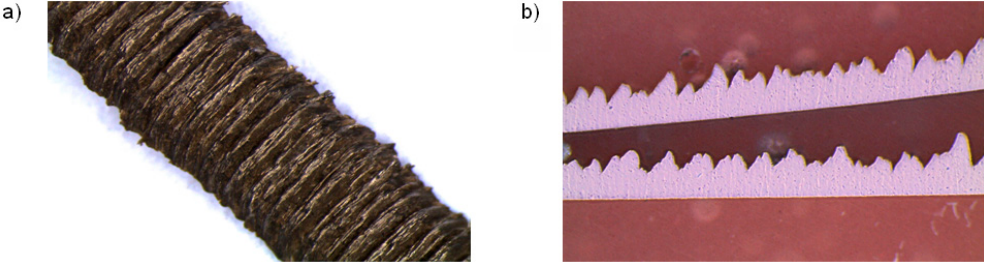
Figure 2. The chip after orthogonal turning with a cutting speed of v c = 50 m/min and a feed of. f = 0.1 mm/rev: ( a ) view of the chip surface at the 10.5× magnification; ( b ) longitudinal section of the chip at the 24× magnification [6].